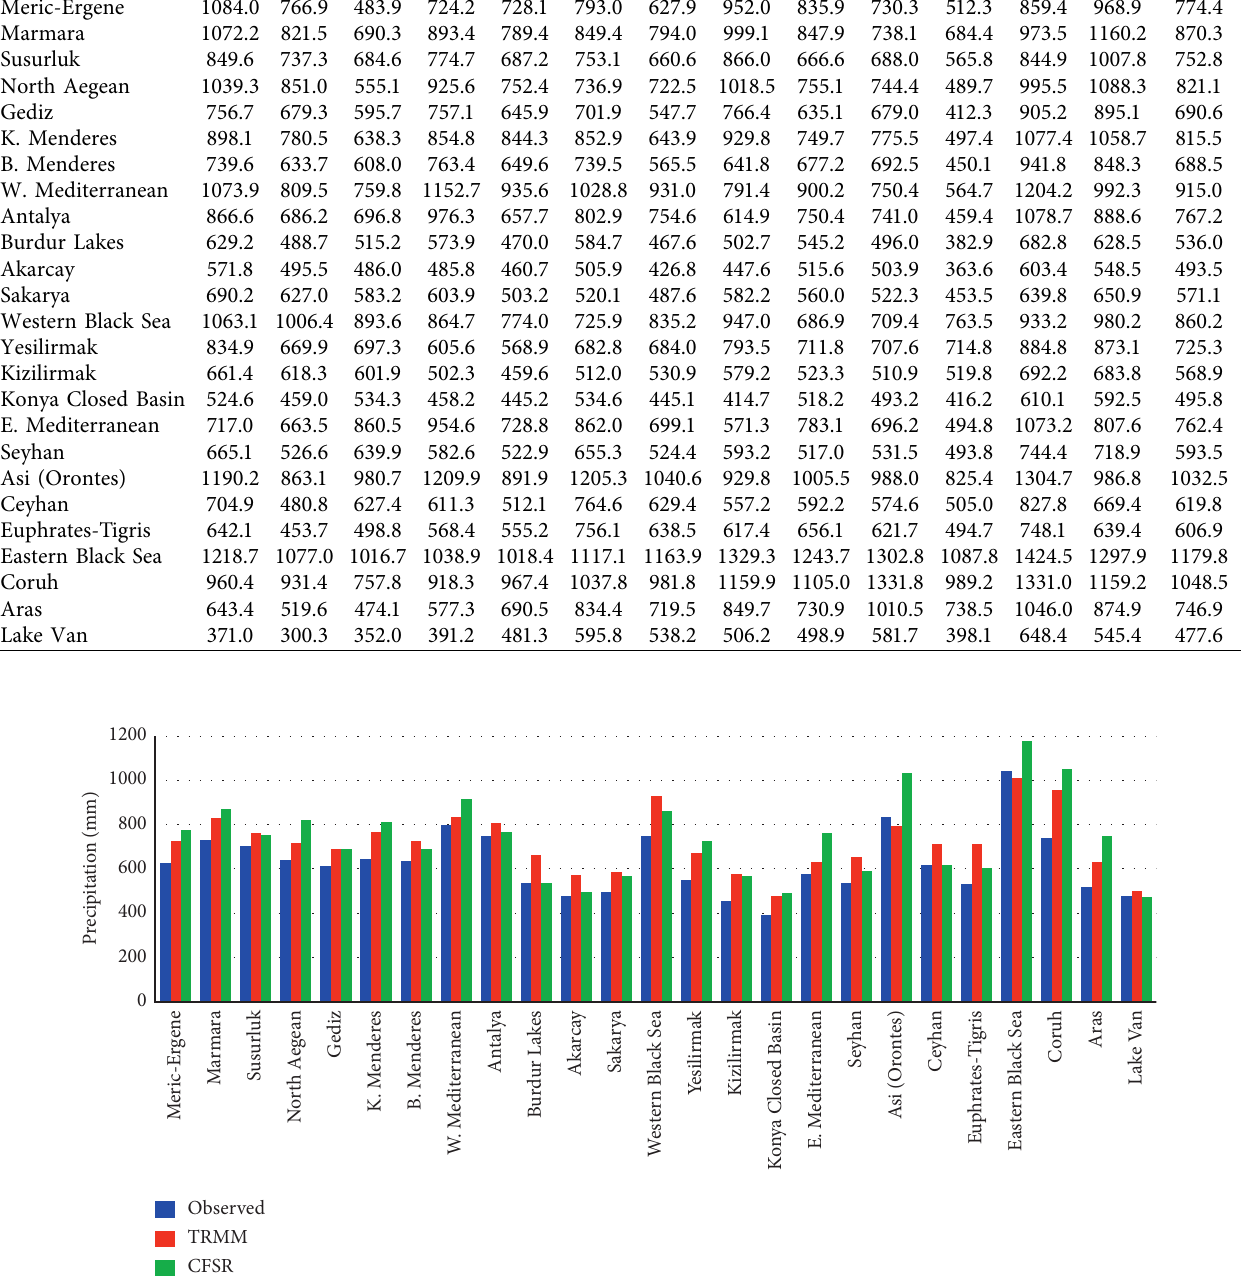
Figure 5: Comparison of observed, CFSR, and TRMM average precipitation